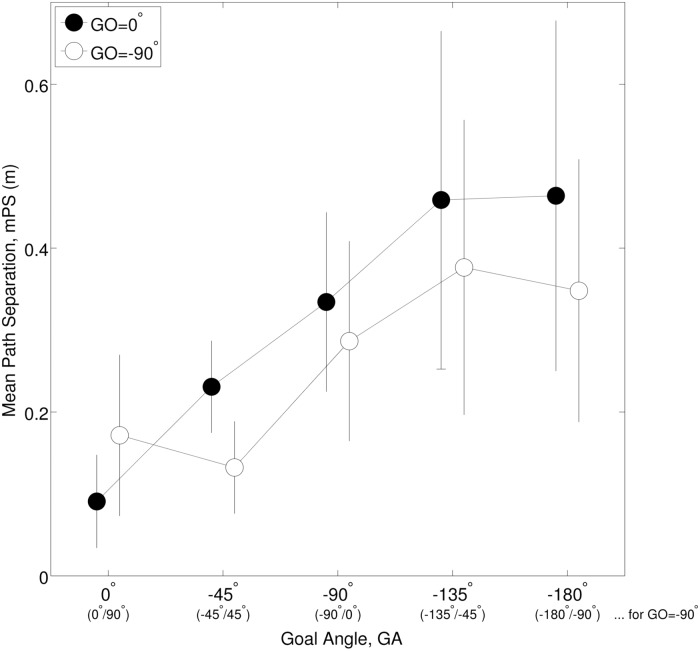
Mean path separation (mPS)—PtP trials.mPS is plotted as a function of goal angle, GA. The labels for x-axis in brackets indicate the anisometric forward-return goal angles for the GO = −90° condition. Error bars indicate standard deviation of the mean over all participants.